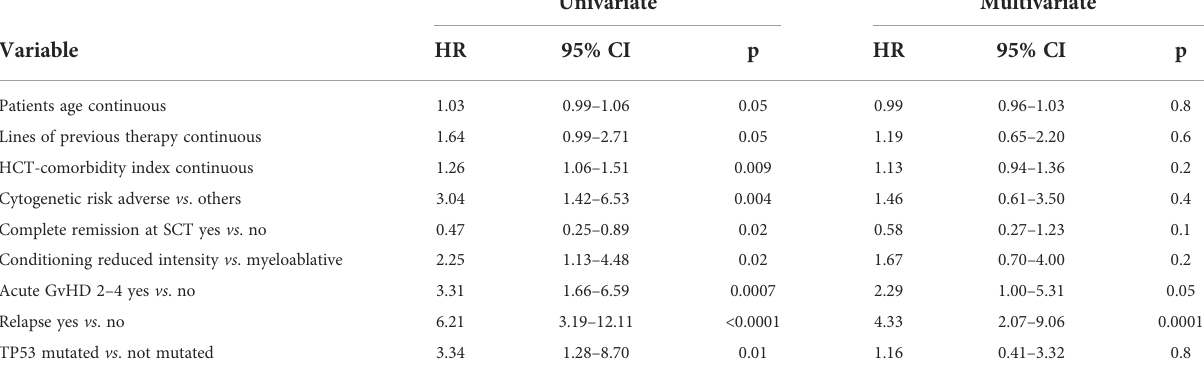
TABLE 4 Cox regression for overall